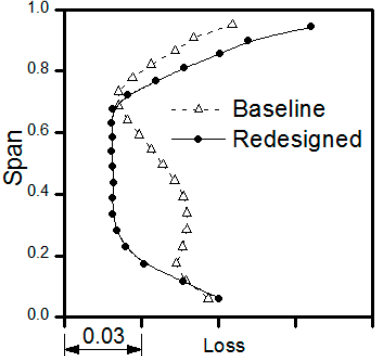
stall points). stall points). Energies 2016 , 9 , 296